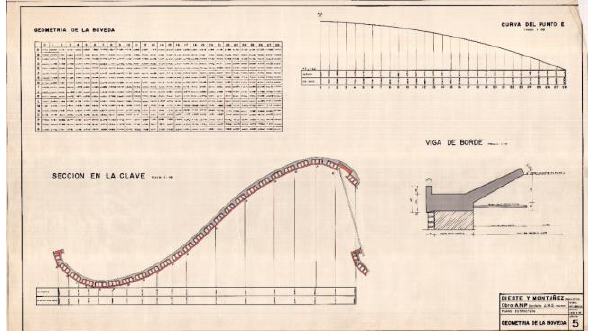
Figure 7: Example of Eladio Dieste’s Seaport Deposit of Montevideo’s original construction drawing sheet obtained during the research. This specific sheet establishes the geometrical coordinates of the Roof Surface.